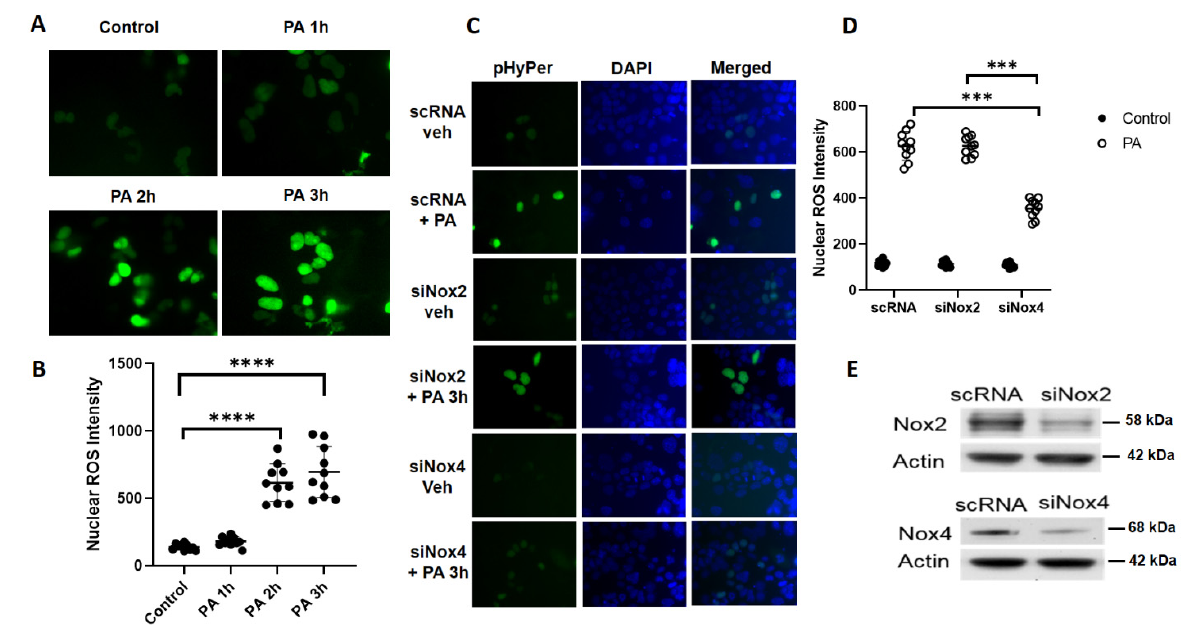
Figure 4. NOX4, but not NOX2, mediates nuclear ROS generation in lung epithelial cells challenged by P. aeruginosa . ( A ) Mouse lung epithelial (MLE) 12 cells grown in 35 mm glass-bottom dishes (~90% confluence) were transfected with scrambled or nuclear reactive oxygen species (ROS) biosensor nuclear-HyPer plasmid (50 nM) for 48 h before exposure to heat-inactivated P. aeruginosa ( PA ) (1 × 10 8 CFU/mL). Nuclear ROS (hydrogen peroxide) production was monitored by live imaging of cells at varying time periods using confocal microscope. Shown is a representative micrograph depicting the green biosensor after PA treatment from three independent experiments. ( B ) Nuclear ROS from ( A ) were quantified by Image J and presented as intensity (at least 20 cells were chosen from each field and minimum of 3–5 different fields from each dish for analysis). Value are means ± SD from three independent experiments. **** p < 0.001. ( C ) MLE12 cells grown to ~70% confluence in 35 mm glass-bottom dishes were transfected with scrambled, Nox2, or Nox4 siRNA (50 nM) for 48 h followed by transfection with nuclear-Hyper plasmid as indicated in ( A ) for 24 h. Cells were challenged with heat-inactivated PA (1 × 10 8 CFU/mL) for 3 h, and production of ROS (hydrogen peroxide) in nucleus was monitored by live imaging (ROS, green; nucleus, DAPI) using a confocal microscope. ( D ) Nuclear ROS production was quantified by Image J and presented as intensity, at least 20 cells from each field and 3–5 fields from each dish were analyzed. Value are means ± SD from three independent experiments. *** p < 0.005. ( E ) Cell lysates (20 μ g protein) from control, Nox2, and Nox4 siRNA-treated cells were subjected to Western blotting to confirm knock down of Nox2 and Nox4 after treatment with specific siRNA compared to scrambled siRNA treated cells. Representative blot is shown.